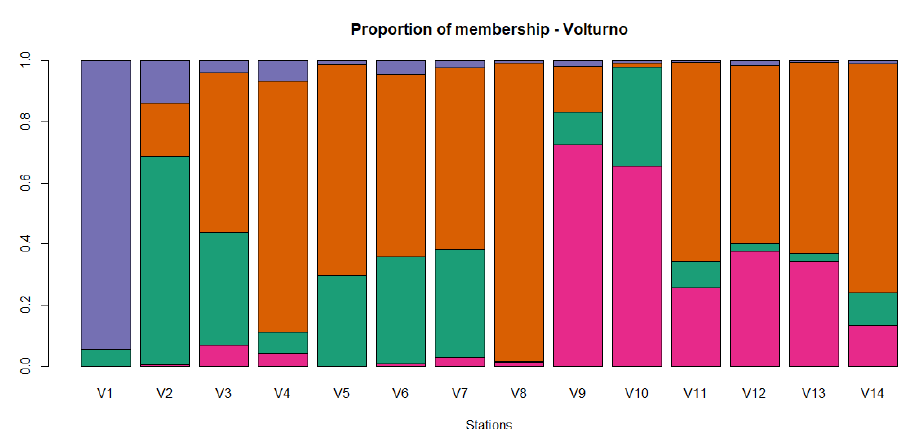
Figure 8. Proportion of membership of each sampling locations in each of the 4 clusters estimated in ADMIXTURE for the Volturno river. Orange, green, pink and violet colors represent group 1, 2, 3 and 4, respectively.